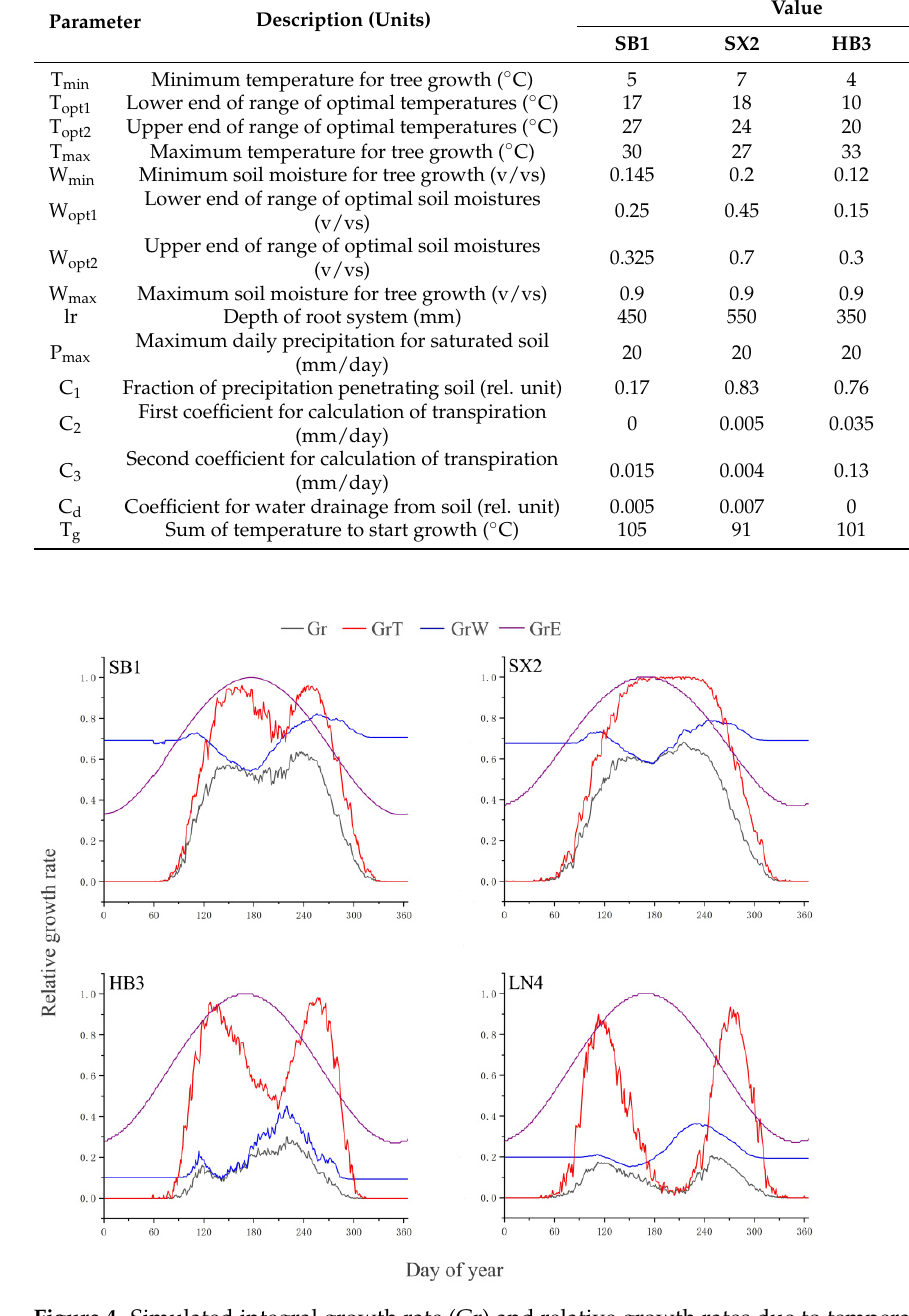
Figure 4. Simulated integral growth rate (Gr) and relative growth rates due to temperature (GrT), soil moisture (GrW), and solar irradiance (GrE) at sampling sites SB1, SX2, HB3, and LN4. The roles of temperature and soil moisture in the radial growth of trees were judged by comparing the differences in the average radial growth rates of extremely wide and extremely narrow years. An extremely wide year is defined as more than one standard deviation from the mean of the simulated chronology; an extremely narrow year is defined as less than one standard deviation from the mean of the simulated chronology. The extremely wide years inferred from SB1, SX2, HB3, and LN4 were years 10, 7, 9, and 11, respectively, while the extremely narrow years were years 9, 10, 7, and 12, respectively (Table 2). Table 2. Years of extremely wide rings and narrow rings.